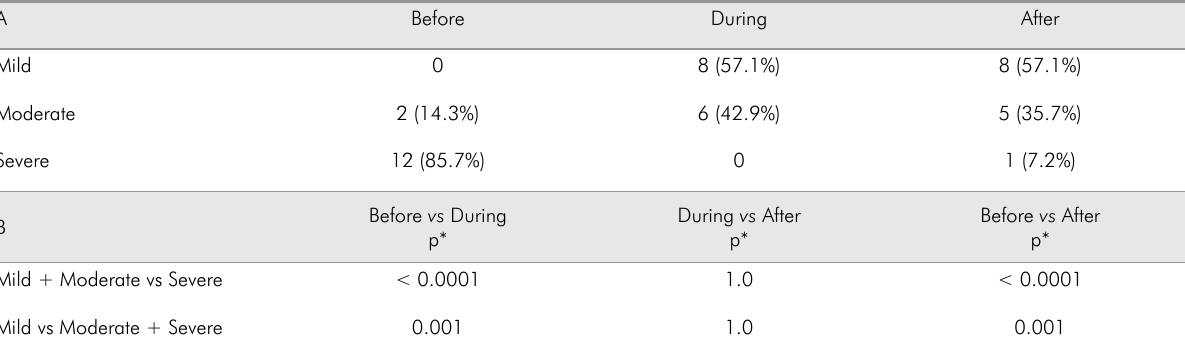
Table 1. (A) Distribution of pain intensity before, during and after arthrocentesis treatment (B) p-values for comparisons between groups.